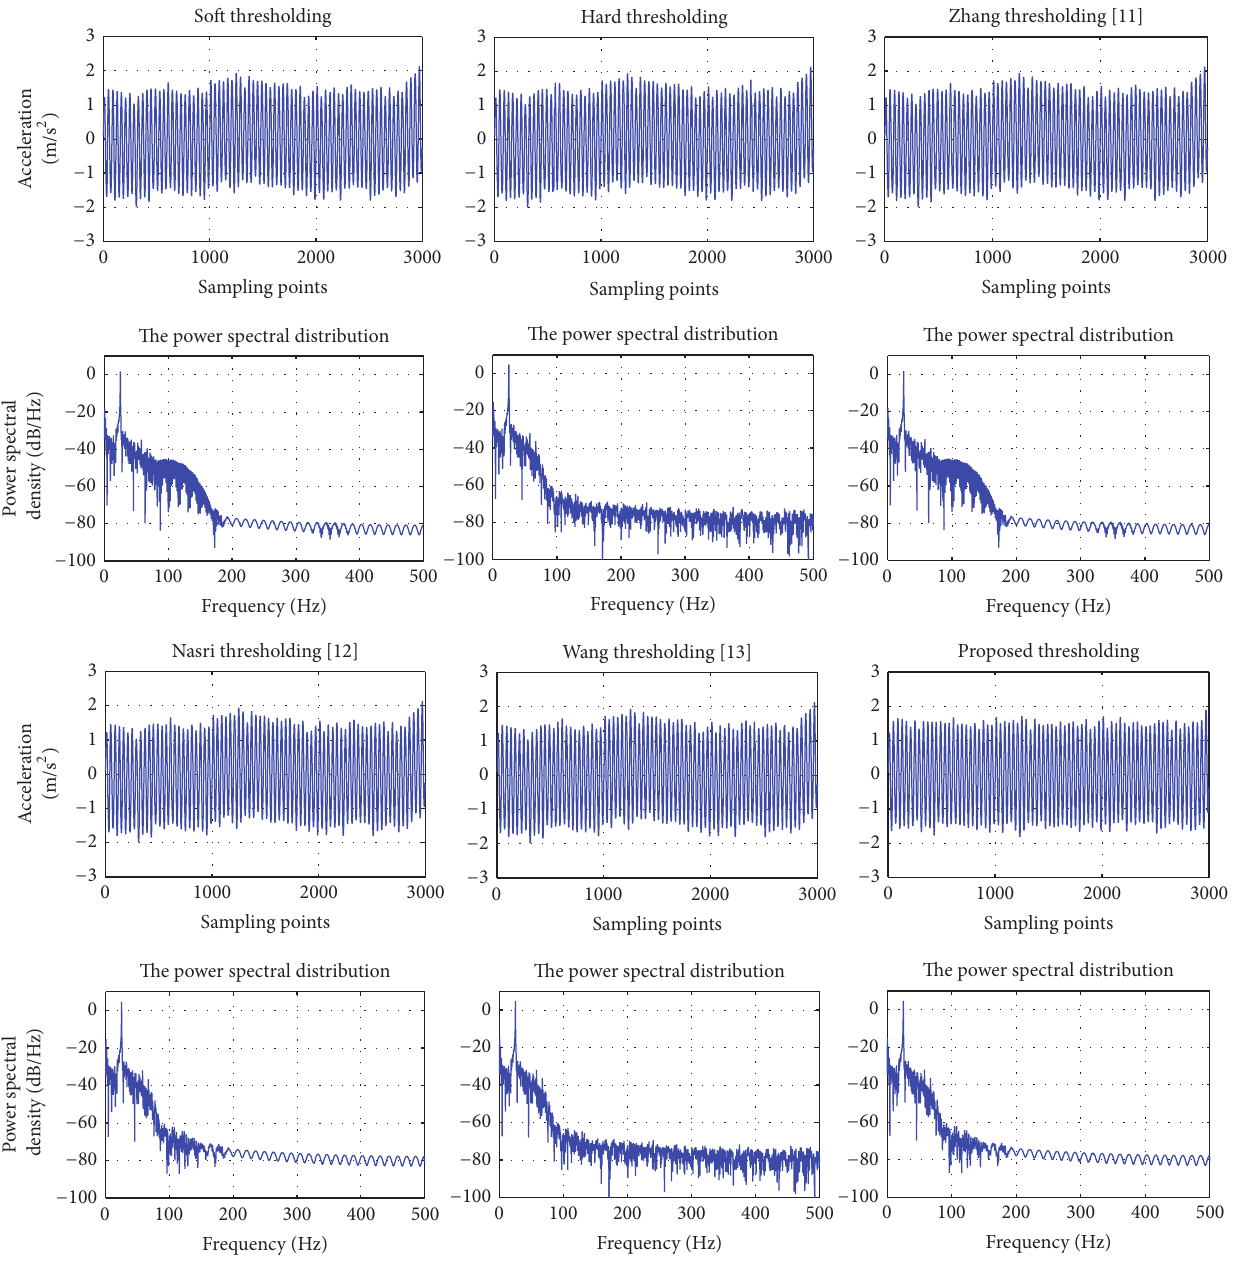
Figure 11: The denoising results of sine VPVS